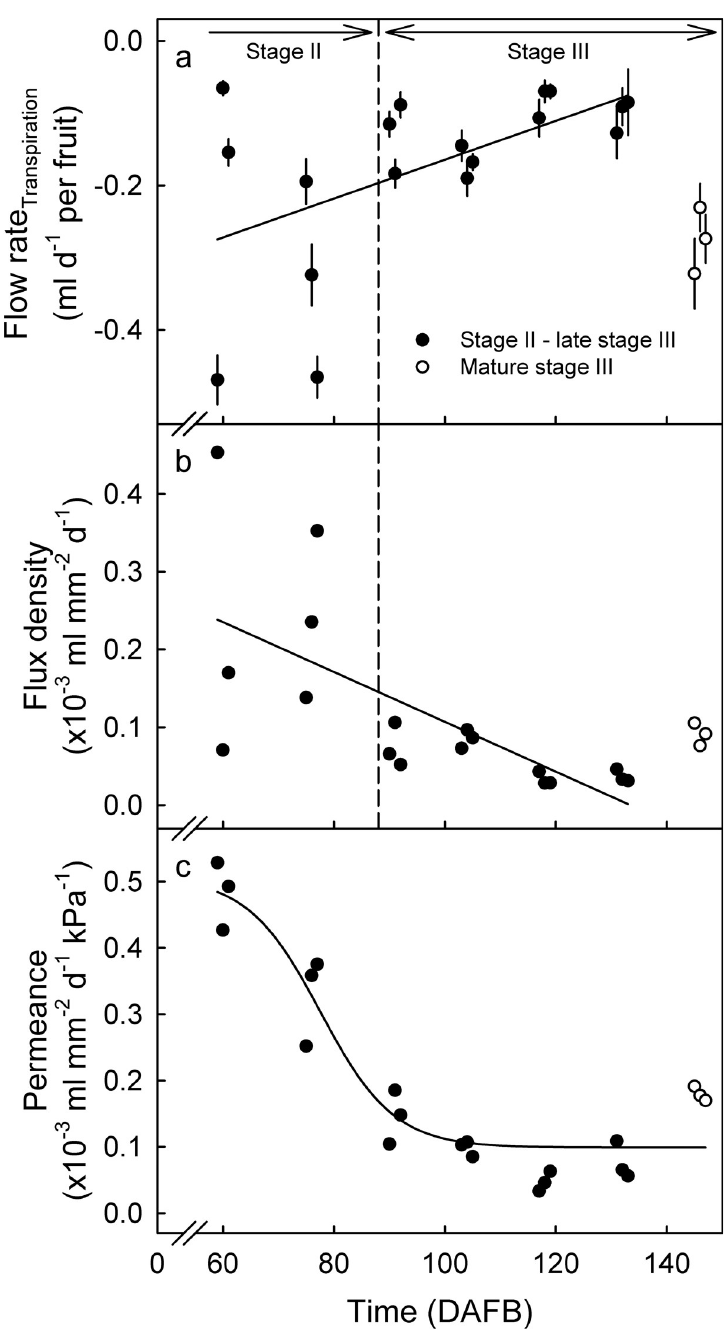
Fig 6. Transpiration of developing European plum fruit. (A) Transpiration rate (per fruit). (B) Transpiration flux density (volume per mm 2 of skin and day). (C) Skin permeance (flux density per unit water vapor pressure deficit (volume per mm 2 of skin and day and VPD)). Transpiration flux density was calculated by dividing the flow rate in transpiration per fruit by fruit surface area. To avoid confusion, the absolute of value of the flux density and skin permeance is shown. Skin permeance was calculated by dividing transpiration flux density by the VPD. The open symbols represent the final sampling date. Because fruit softening may slightly affect the measurement of fruit diameter change by a lightly spring-loaded linear variable displacement transducer, data for the last sampling period were excluded from the regression analysis as this is when fruit softening would have been most pronounced. Data in Fig 6A represent means ±